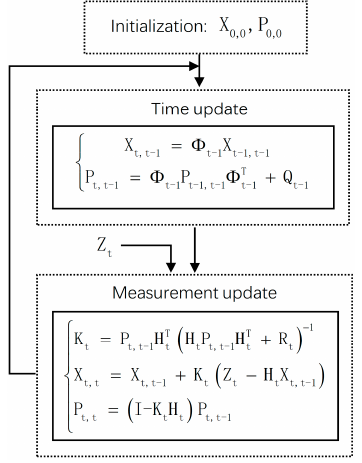
Figure 6. KF Algorithm